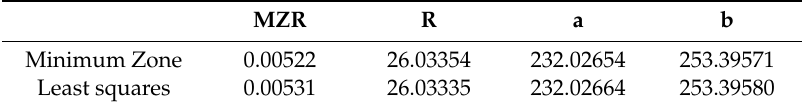
Table 4. Roundness measurement results of Case 5. Roundness from dataset Table A3. Values in (mm).